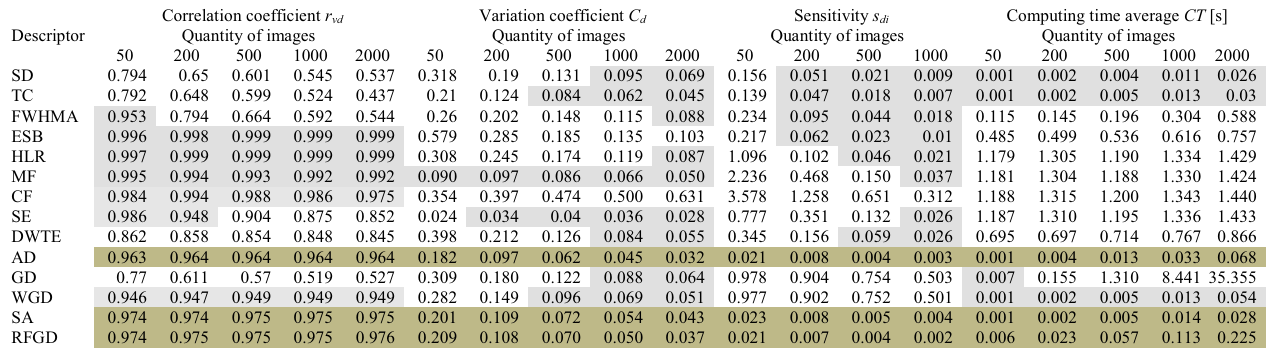
Table 1. Correlation, Variation coefficient, Sensitivity and Computing Time average Correlation coefficient r vd